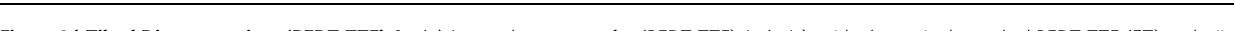
Figure 1 | Tilted Dirac cones in a -(BEDT-TTF) 2 I 3 . ( a ) Layered structure of a -(BEDT-TTF) 2 I 3 ( a -I 3 ), with alternatingly stacked BEDT-TTF (ET) and triiodide (I 3 ) layers. Balls-and-stick diagram represents the molecular structures, where sticks indicate bonds; red, blue and green balls stand for carbon atoms; grey balls are sulphur atoms; and big purple balls indicate iodine atoms. One electron per two ETs is donated to a I 3 molecule due to charge transfer, constituting a quasi-2D (hole) conducting system in (ET) 2 þ layers and non-magnetic insulting I 3 (cid:2) layers. Inset of ( a ): The structure of a ET molecule. 13 C isotopes, substituted for 13 C-NMR, are indicated by arrows. ( b ) 2D unit cell with four ETsites in the ab -plane, distinguished as the site j ¼ A ( ¼ A’ ) (blue), B (green) and C (red). Same colour correspondence as in a . The dashed rectangle indicates the unit cell, and crosses stand for the inversion centre. ( c ) Electronic band structure of a -I 3 at high pressures ( P 4 P C ; see g ) 25 . As the band is 3/4-filled owing to the charge transfer, the Fermi energy E F ( ¼ 0) is present between the first ( z ¼ þ ) and second ( z ¼ (cid:2) ) bands from the top. Gapless points appear at E F and locate at ± k D in the first Brillouin zone, around which a pair of tilted Dirac cones are visible (indicated by circles). Wave vectors ( k x and k y ) are given in the r.l.u. ( d – f ) The calculated titled Dirac cone around E F ( ¼ 0) plotted as a function of the wave vector q ¼ k (cid:2) k D ¼ ( q x , q y ). The label bar stands for the size of the site-spectral weight, n z non-equivalent site j ¼ A ( ¼ A’ ) ( d ), B ( e ) and C ( f ) 25 (equation (11) in Methods). The magnitude is normalized to the maximum value of n z ( g ) The pressure–temperature ( P – T ) phase diagram. The charge ordering temperature T CO (squares) is determined from the electrical resistance ( R ) measurements 39 , defined as the maximum of (cid:2) d (ln R )/ T . Error bars follow those provided in ref. 39. At T ¼ 0, the phase boundary locates at P C E 1.2GPa as determined from a linear extrapolation (solid line), corresponding to d T CO /d P E –110KGPa (cid:2) 1 . r.l.u., reciprocal lattice